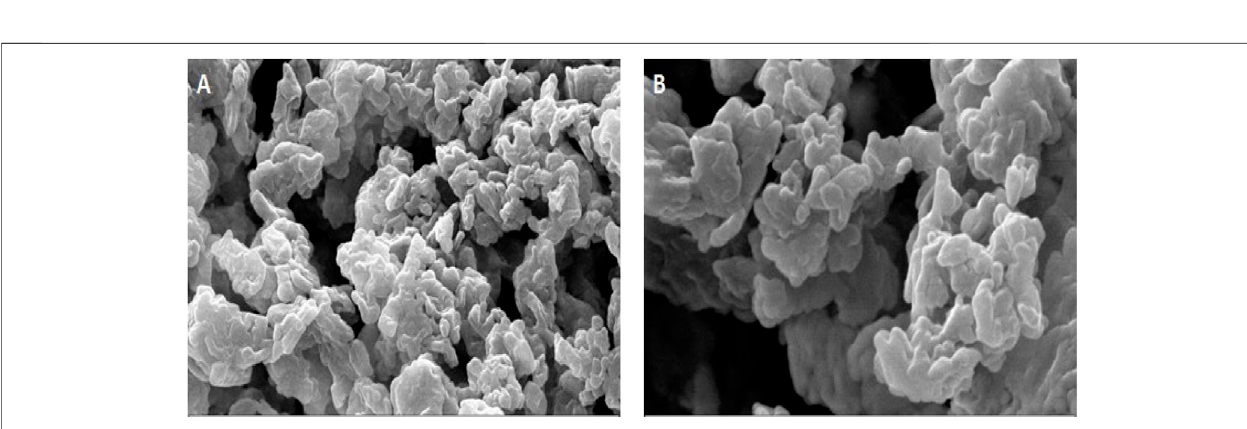
was obtained with a linear relationship (Y = 0.008x + 0.0075) and